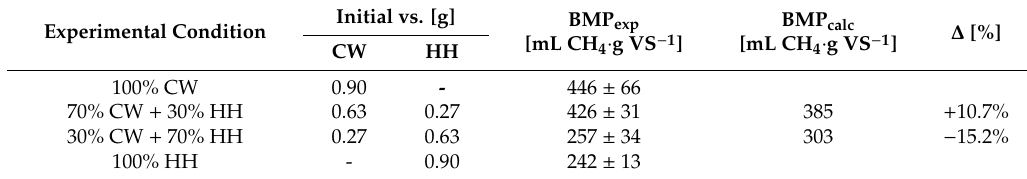
Table 2. Final specific biochemical methane potential (BMP) obtained after 42 days under the four di ff erent substrate combinations used. The biomethane yields calculated (BMP calc ) considering the 30% and 70% of the BMP experimentally obtained (BMP exp ) with 100% cheese whey (CW) and 100% hemp hurds (HH) are also reported. ∆ is the variation between BMP exp and the corresponding BMP calc owing to co-digestion. VS: volatile